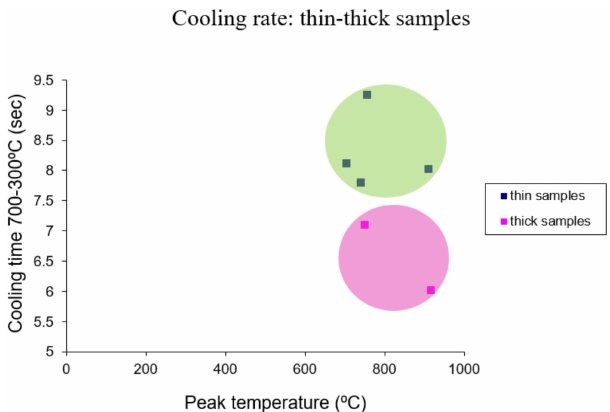
Figure 12. The effect of the thickness of the samples on the cooling rate.